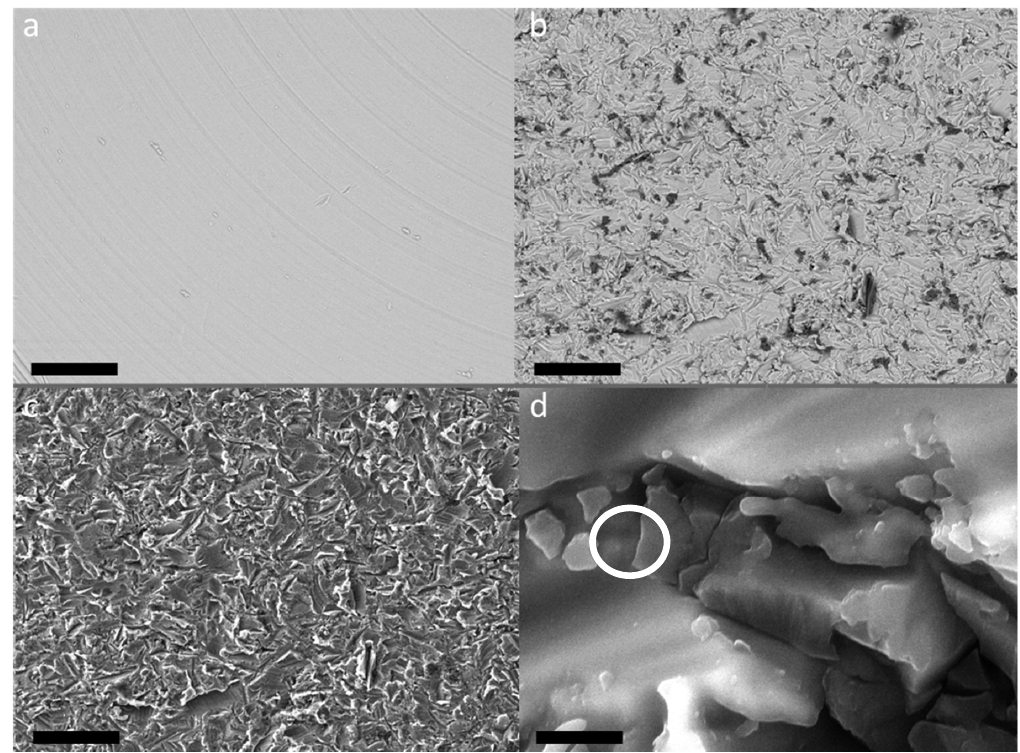
Figure 5. SEM images. ( a ) CP1, BSE detector, 500 × , bar scale 100 µ m; ( b ) CP4, BSE detector, 500 × , bar scale 100 µ m; ( c ) same area of b taken with SE detector, 500 × , bar scale 100 µ m; ( d ) CP4, SE detector, 25,000 × , bar scale 2 µ m. The grain evidenced by the white circle has been used to obtain EDS spectrum reported in Figure 6.